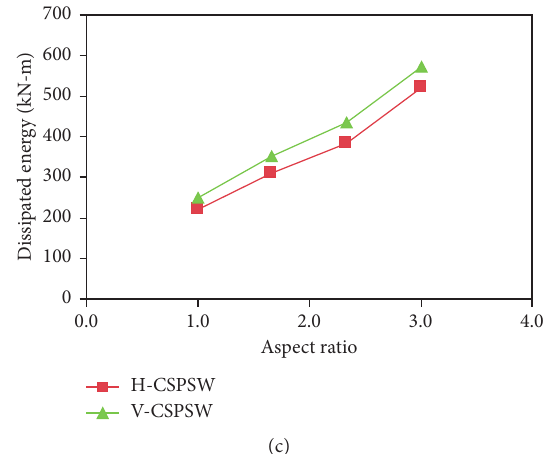
Figure 18: The responses of H-CSPSW and V-CSPSW as functions of infill plate aspect ratio. (a) Initial stiffness. (b) Ultimate strength. (c) Dissipated energy.